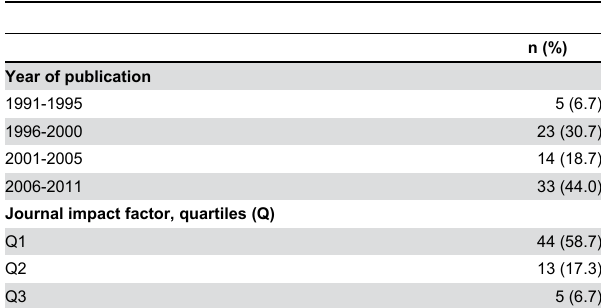
Table 1. Characteristics of articles included in the study